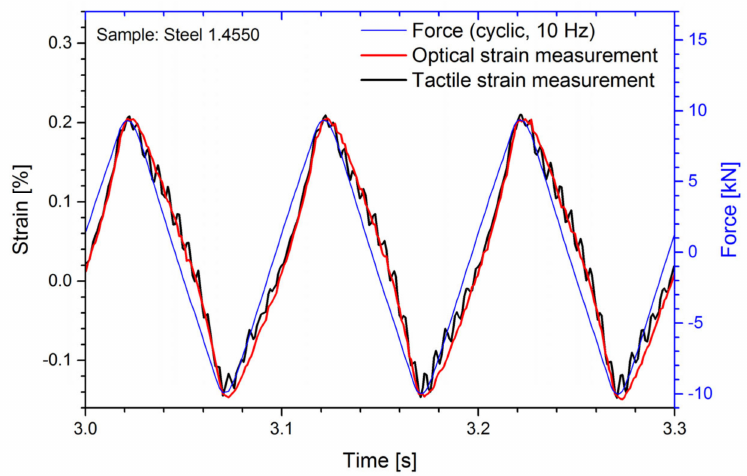
Figure 5. Force-controlled test on austenitic steel 1.4550 at room temperature with a 10 Hz triangular force-controlled cycle. The optical system (red curve) resolves the turning points as well as the tactile mechanical extensometer (black curve).